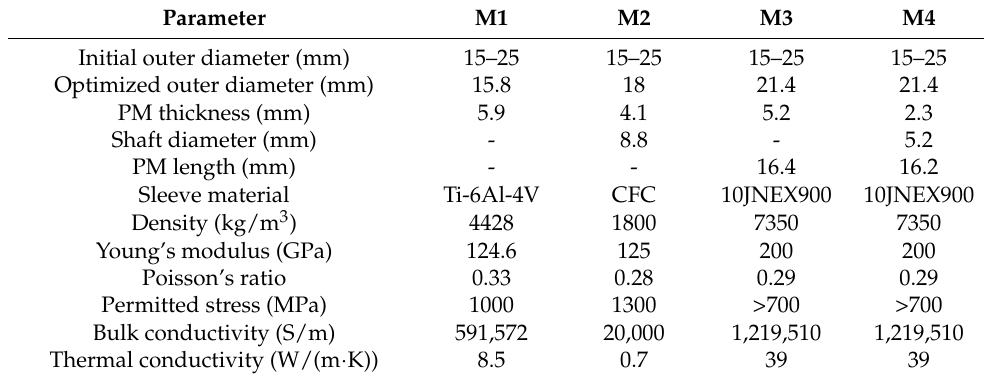
Table 2. Main parameters and material properties of